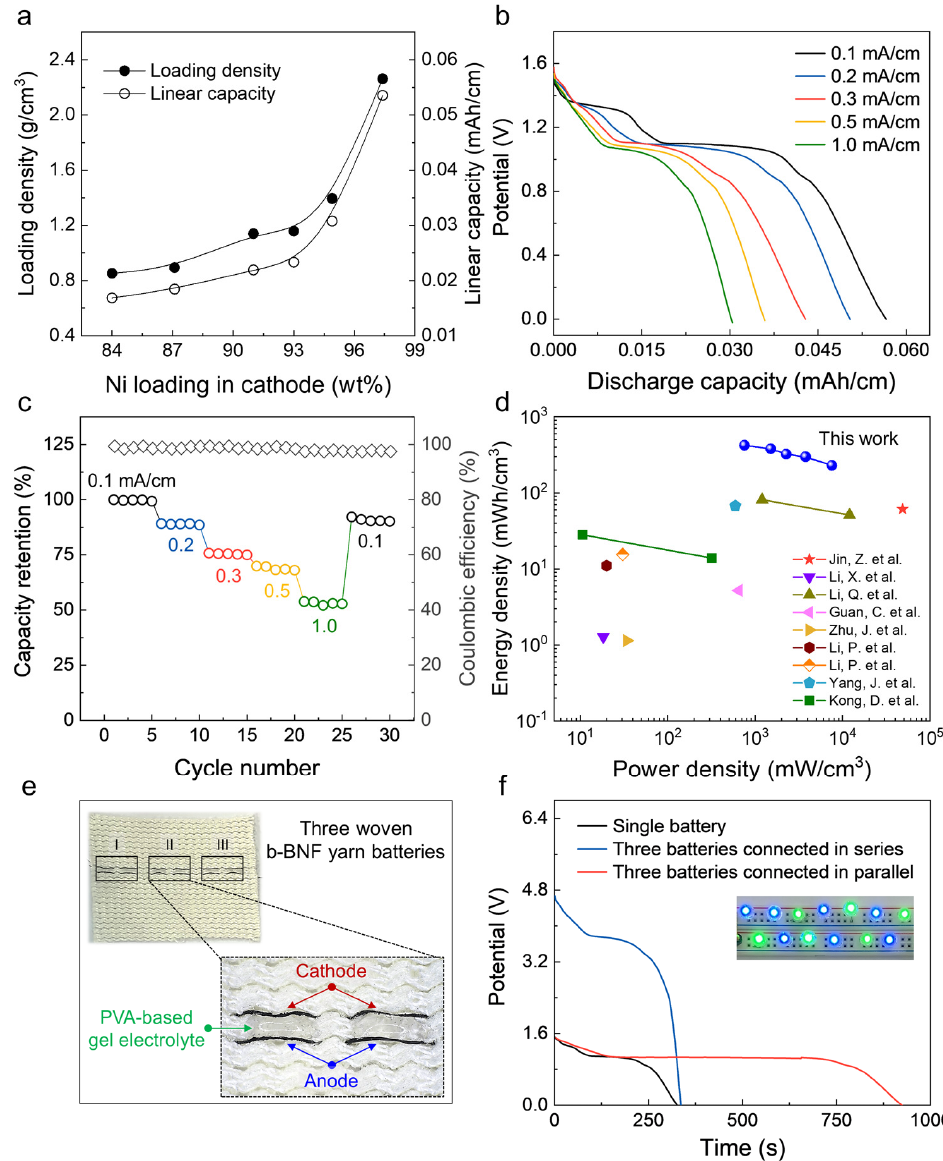
Figure 3. Performances of the b–BNF yarn batteries and demonstration as a practical power source. ( a ) Linear capacity versus Fe load in anode (Ni–to–Fe mass ratio is 1.8:1). ( b ) Galvanostatic discharge curves at different current densities. ( c ) Capacity retention and corresponding coulombic efficiency of b–BNF yarn battery. ( d ) Ragone plot of as–fabricated Ni–Fe battery (based on total volume of the cathode and anode) [45–53]. ( e ) Photographs showing three b–BNF yarn batteries woven into a com- mercial textile. Inset shows that each cell consists of a 3 cm–long Ni(OH) 2 cathode yarn and a 3 cm– long Fe 3 O 4 anode yarn with a gel electrolyte (PVA–KOH). ( f ) Galvanostatic discharge curves of sin- gle b–BNF yarn battery (black curve) and three batteries connected in series (blue curve) and parallel (red curve) at 1 mA/cm. The inset shows 13 LEDs (seven blue and six green) illuminated by three serial–connected b–BNF yarn batteries. To demonstrate the viability for power source application in wearable electronic de- vices, the three b–BNF yarn batteries were assembled in series or parallel. Figure 3e ex- hibits that 3 cm long, three b–BNF yarn batteries can be woven into a commercial textile with a poly(vinyl alcohol) (PVA) gel electrolyte owing to their mechanical strength and flexibility. According to the discharge curves (Figure 3f), the voltage and capacity are tri- pled for the serial (blue line) and parallel (red line) assemblies, respectively, thereby in- creasing the power and energy output. Because of their high energy/power density, the woven BNF yarn batteries can simultaneously power and light up seven blue LEDs and six green LEDs with a dazzling brightness (inset of Figure 3f).